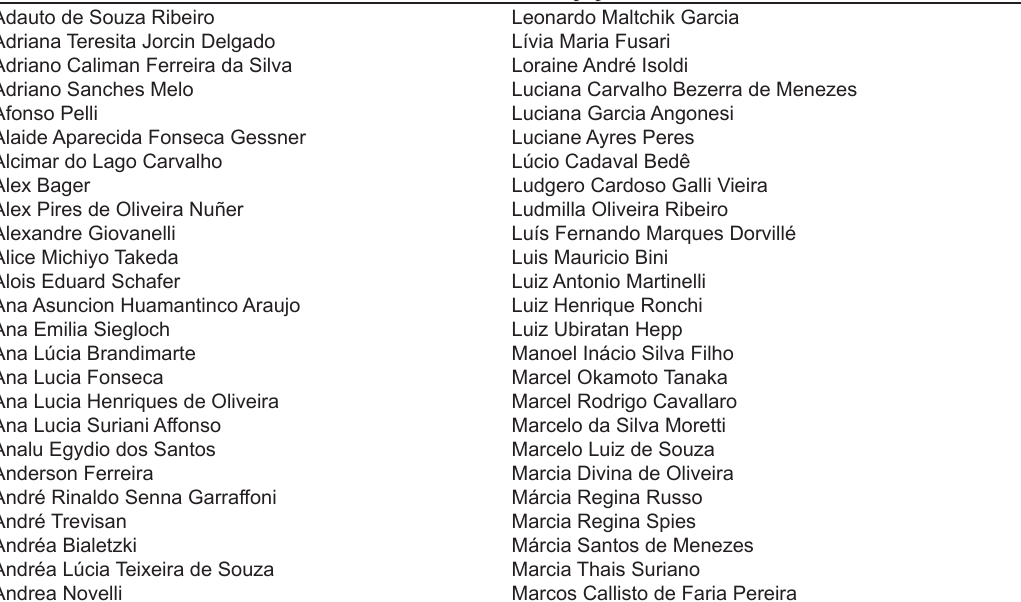
Table 1. Names of researchers whose curricula were used in this